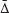
Visualization of permutation tests of father exceptionality centered around the observed  when fathers were excluded from the sample of partners and normalized along the SD of expected  distribution in such a situation. Difference between observed and expected values is expressed in standard deviations of expected value distribution. The higher the bell curve above the observed  value, the more exceptional were the fathers among the long-term partners of an individual. Bell curve below the observed  value indicates a trait where fathers were more typical representatives of an individual’s long-term partners.